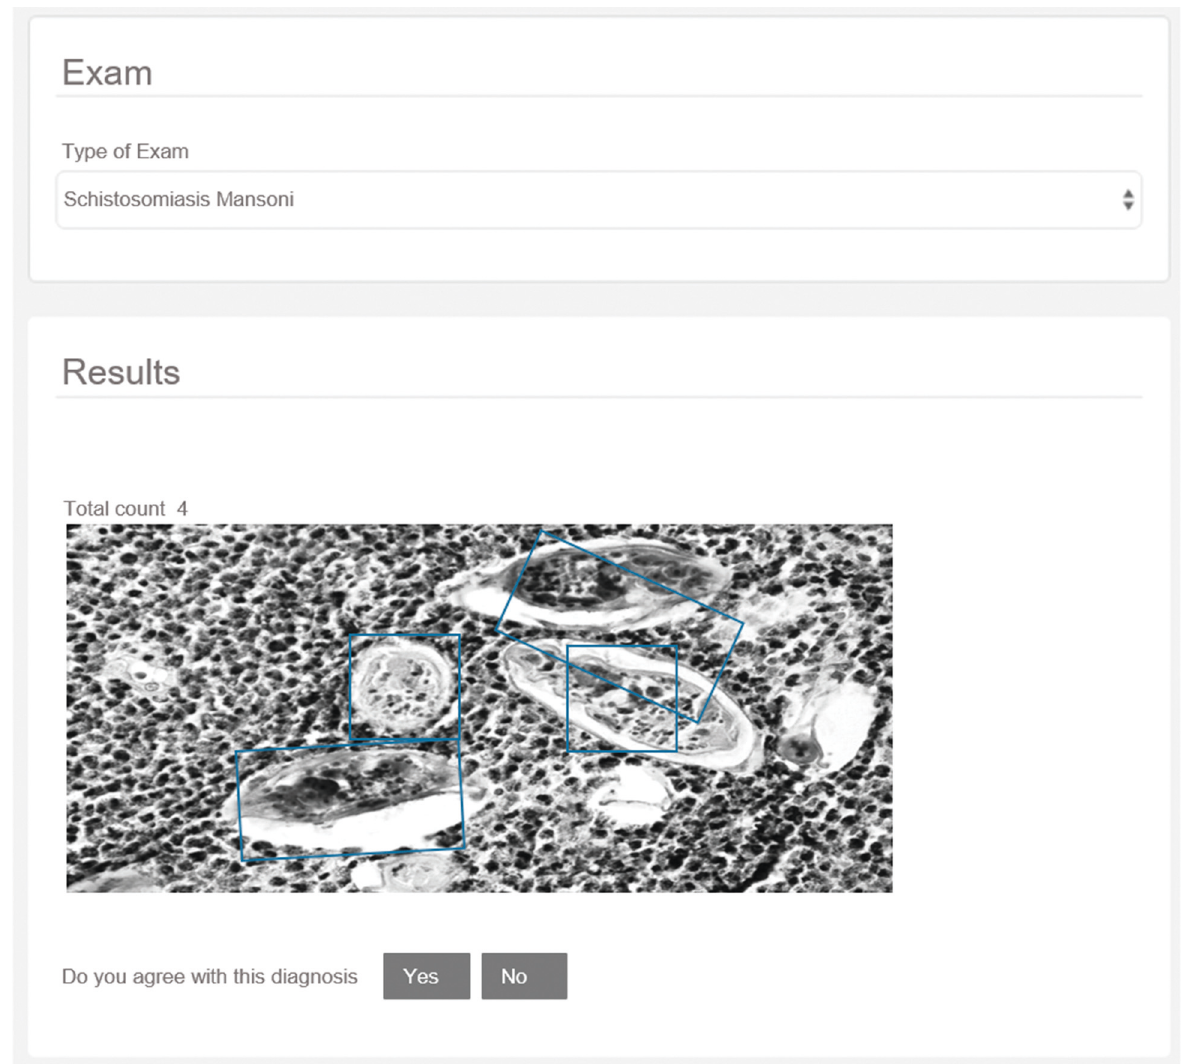
Figure 2: Pick cells system segmenting images of schistosomiasis eggs.